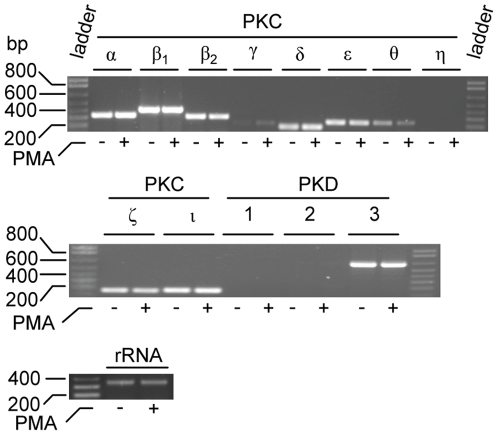
PKC and PKD isoenzymes expressed in THP-1 cells.RT-PCR was used to detect the PKC and PKD isoenzyme mRNA present in cells incubated in the absence (−) or presence (+) of 10-7 M PMA. To ensure that equal amounts of cDNA has been used in samples from control and PMA stimulated cells, rRNA was used as a standard. The probes used are described in Materials and Methods. Ladder is a marker with DNA fragments of known size (in bp).